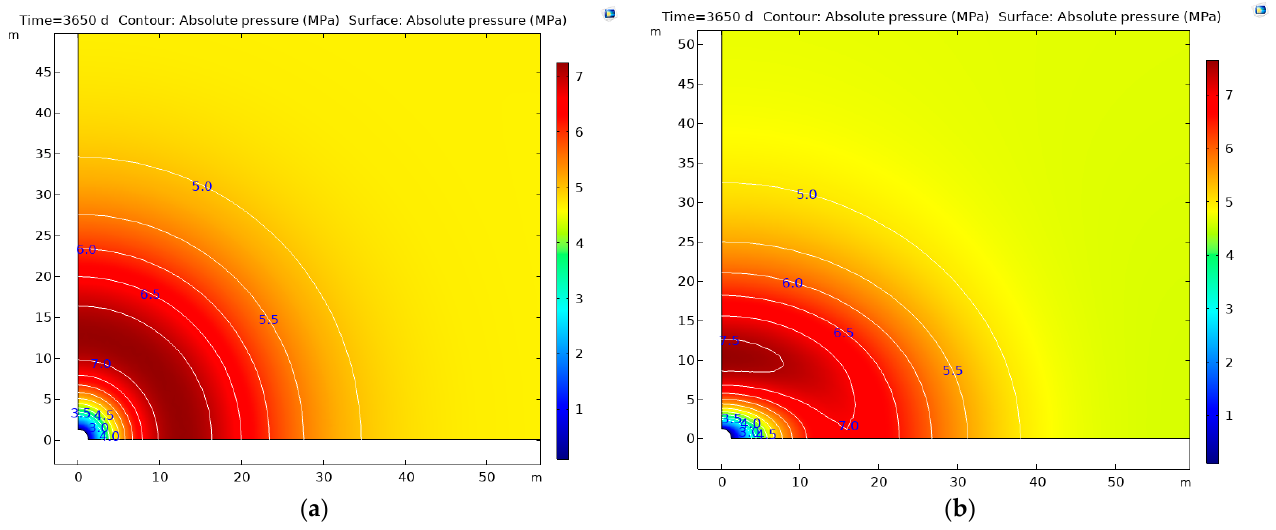
Figure 6. DC variant: distribution of pore pressure by the end of the heating phase (after 3650 days of simulation): ( a ) in the case of isotropic stress conditions and isotropic properties: ( b ) in the case of anisotropic stress and anisotropic properties).